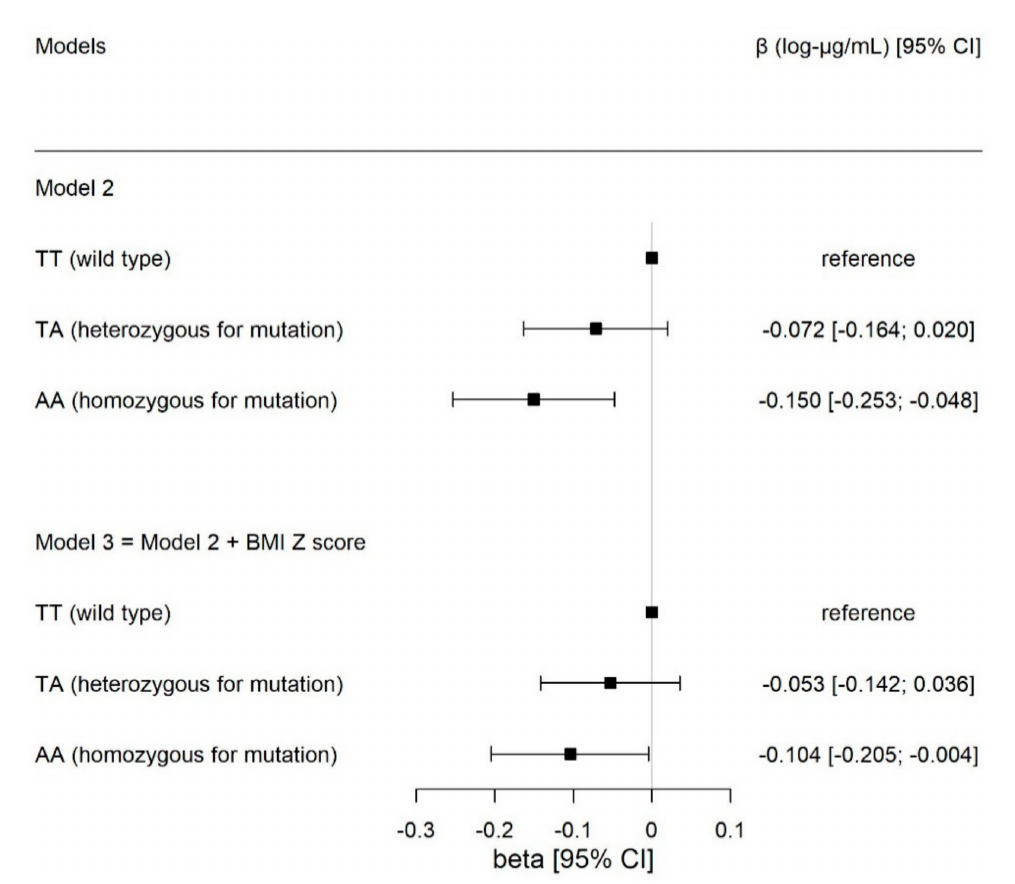
Figure 2. Associations between circulating adiponectin concentrations in log − transformed µ g/mL, with FTO genotype for SNP rs9939609, comparing carriers of the heterozygous (TA) and homozygous (AA) genotype for the mutation, with the wild-type individuals (TT, reference group), respectively. The results are expressed in beta effect estimates of and their respective 95% CIs. Model 2 was adjusted for age, sex, and Tanner’s stage. Model 3 included the adjustments in model 2 plus BMI